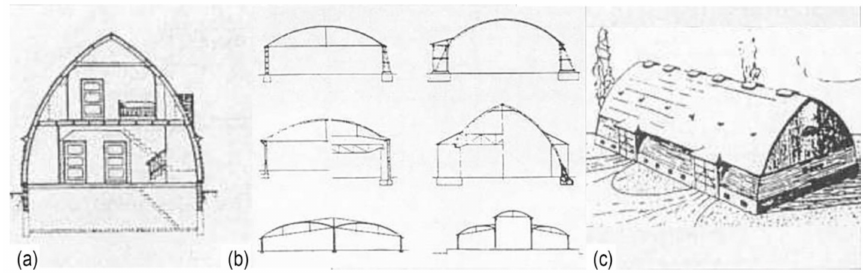
Figure 1. Lamella roofs for ( a ) housing, ( b ) halls and ( c ) barns [5]. The roof is constructed out of timber lamellae with variable cross-section and the upper edge was shaped to follow the arch of the roof. Lamellae were all uniform in shape and size. Two types of lamellae were applied, based on the roof span. The dimensions of the first type were width/height/length = b/h/L = 2.5/15/190 cm and the second were b/h/L = 5/30/150 cm (Figure 2) [6]. When the need for production halls with large spans increased, so did the cross-section of the lamellae, which showed great deflections right after the construction [7]. Other architects started experimenting with the change of disposition and the doubling of the lamellae [7,8], but soon new types of lamella structures were designed, using steel elements and purlins as reinforcement [7,9].